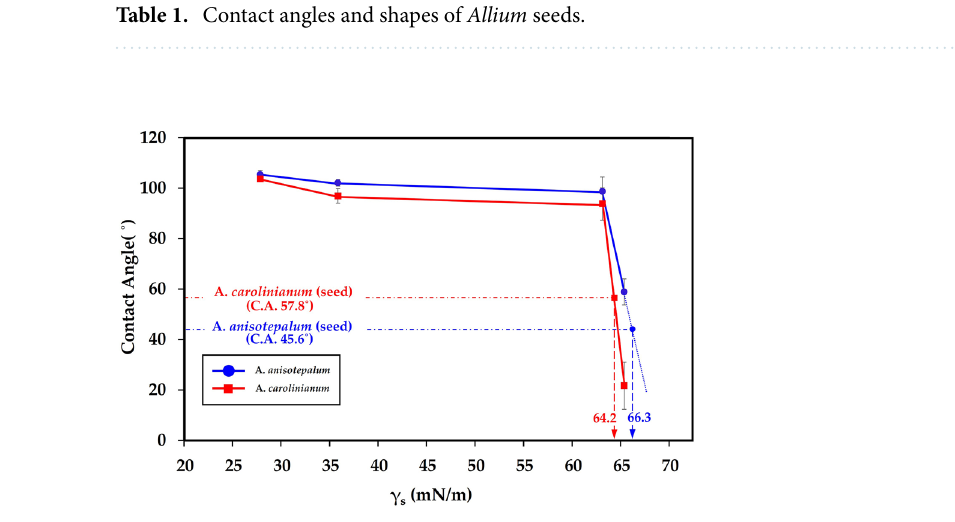
Figure 3. Apparent contact angle according to the surface energy of synthetic Allium seed